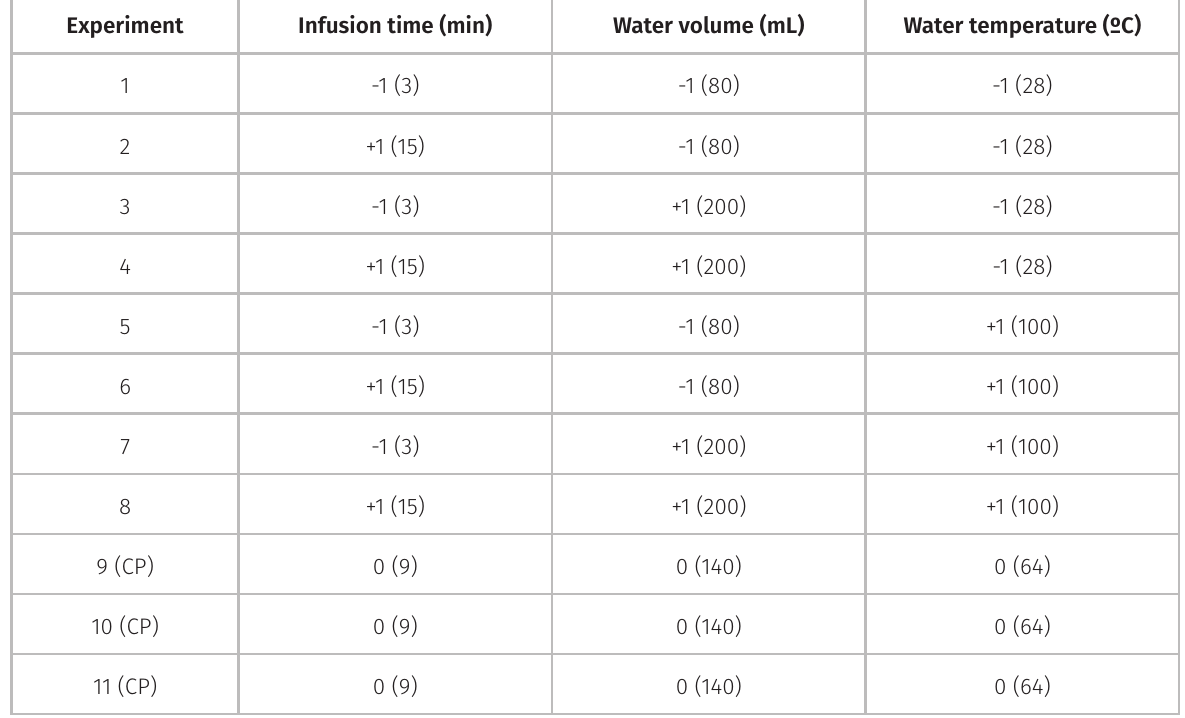
Table I. 2 3 complete factorial planning